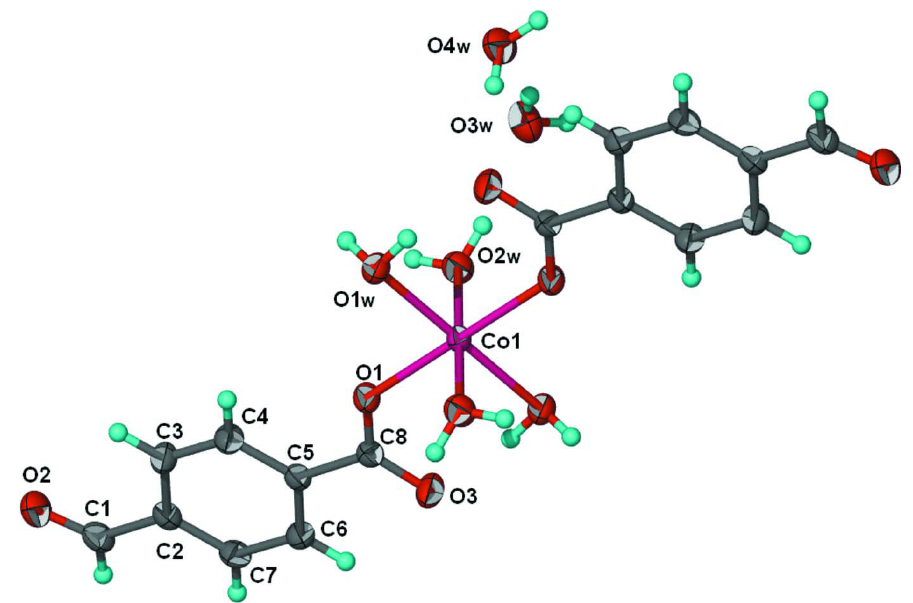
Figure 1 Anisotropic displacement parameter plot of (I). Displacement ellipsoids are drawn at the 50% probability level and H atoms as spheres of arbitrary